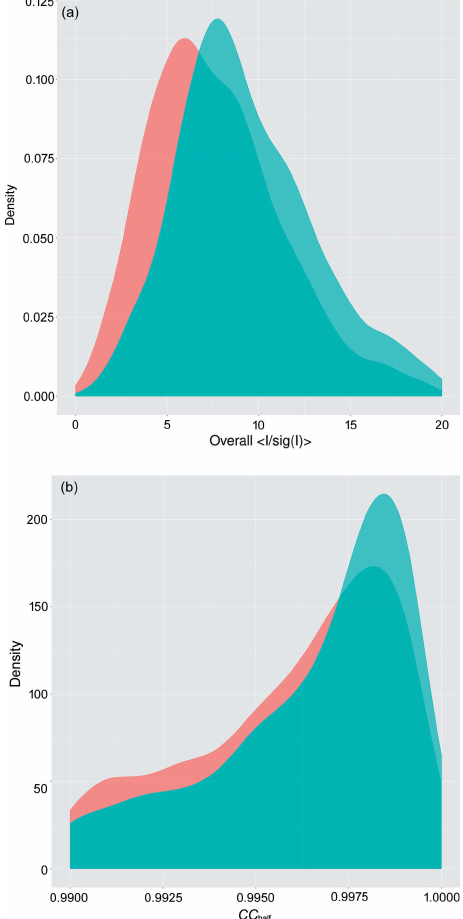
Figure 5 ( a ) Kernel densities of overall h I / (cid:2) ( I ) i for the six months of operation preceding the EBS upgrade (red) and six months of operation post-EBS upgrade (green). ( b ) Overall CC 1/2